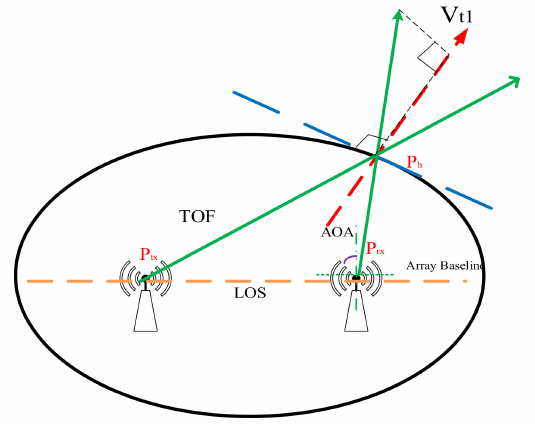
Figure 5. Velocity direction calculation